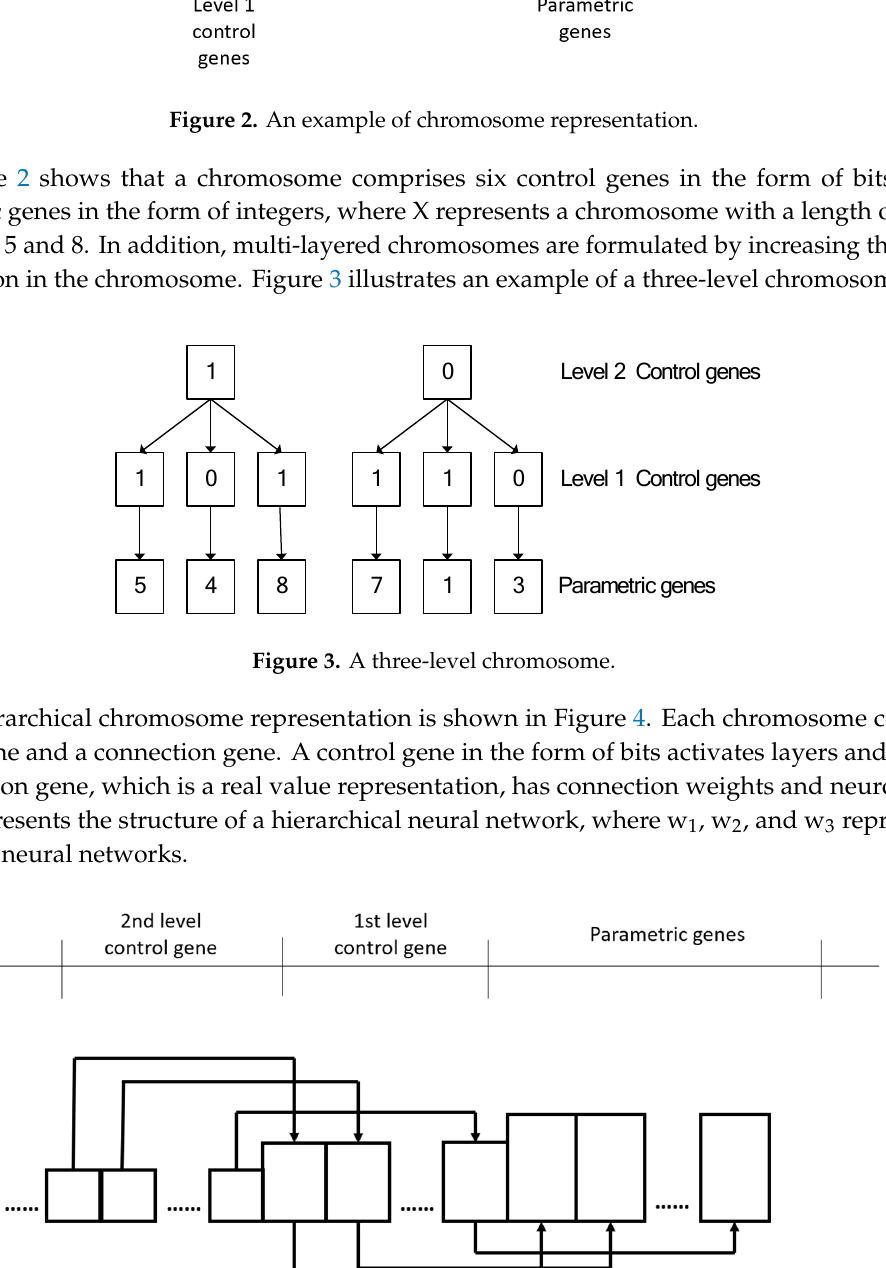
Figure 4. Hierarchical structure of the chromosome.